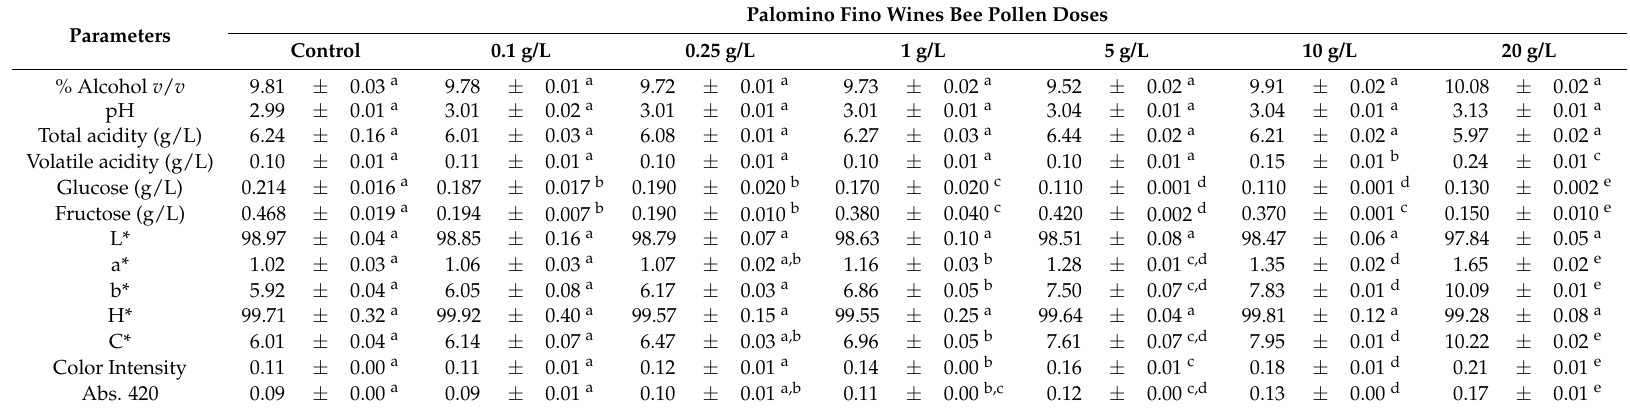
Table 3. Physico-chemical parameters of Palomino fino wines with bee pollen addition (0.1, 0.25, 1, 5, 10 and 20 g/L) and control.